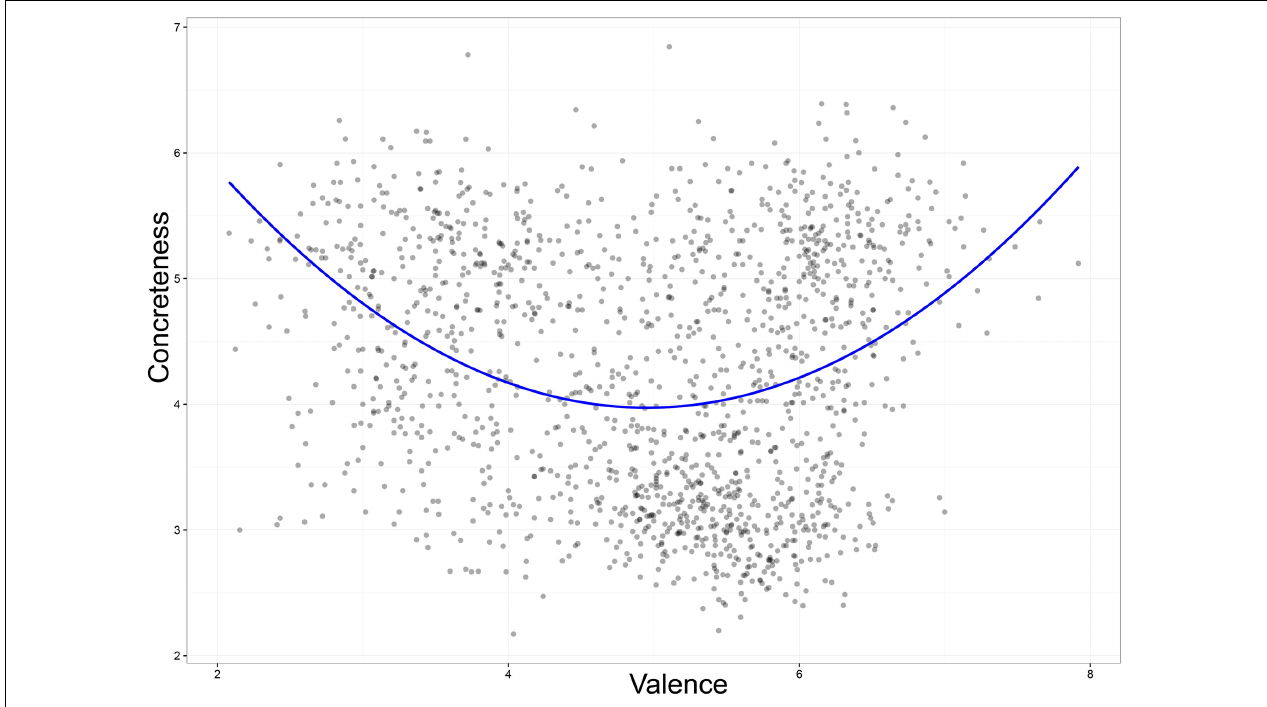
FIGURE 6 | Valence ratings plotted against Concreteness ratings.